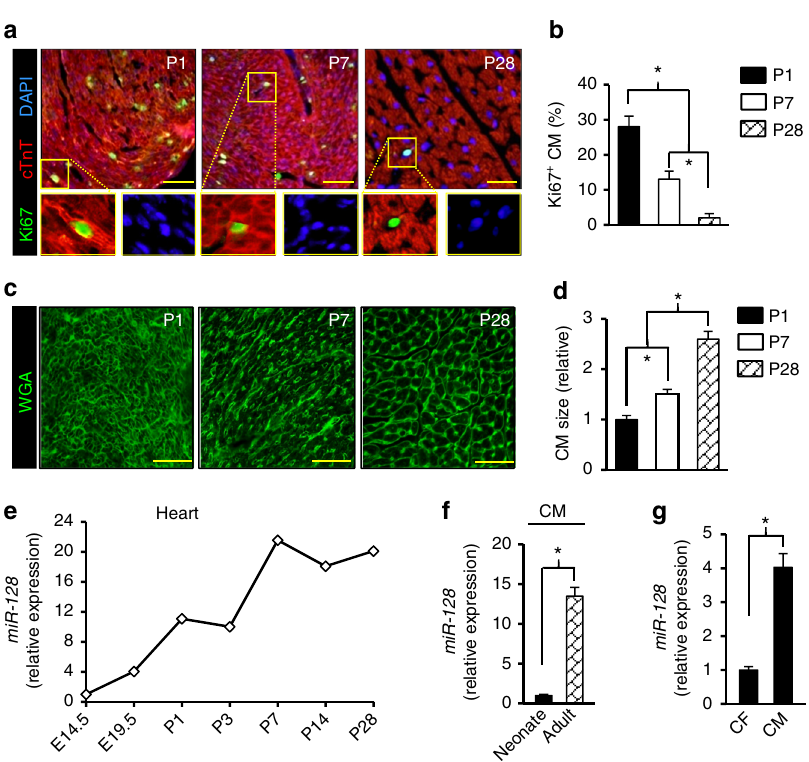
Fig. 1 MiR-128 increases as the heart progresses from neonate to adult. a Evaluation of wild-type mouse cardiomyocyte (CM) proliferative activity using Ki67 immunostaining at postnatal day 1 (P1), P7, and P28. Scale bars, 25 µ m. b Percentage of CM Ki67 + /cTnT + in P1, P7, and P28 hearts ( n = 5 mice for each time point, ~600 CMs/heart). c Wheat germ agglutinin (WGA) staining of P1, P7, and P28 hearts. Scale bars, 25 µ m. d Quanti fi cation of CM size in P1, P7, and P28 hearts stained with WGA ( n = 5 mice for each time point, ~250 CMs/heart). e Evaluation of miR-128 expression level during heart development using qPCR analysis, including embryonic day 14.5 (E14.5), E19.5, P1, P3, P7, P14, and P28 hearts ( n = 5). f qPCR analysis of miR-128 expression in neonatal (P1) and adult (P28) CMs ( n = 5). g Comparison of miR-128 expression by qPCR in cardiac fi broblast (CF) and CMs ( n = 5). Statistical signi fi cance was calculated using ANOVA in b , d and Student ’ s t -test in f , g . Data are represented as means ± SEM. * P <